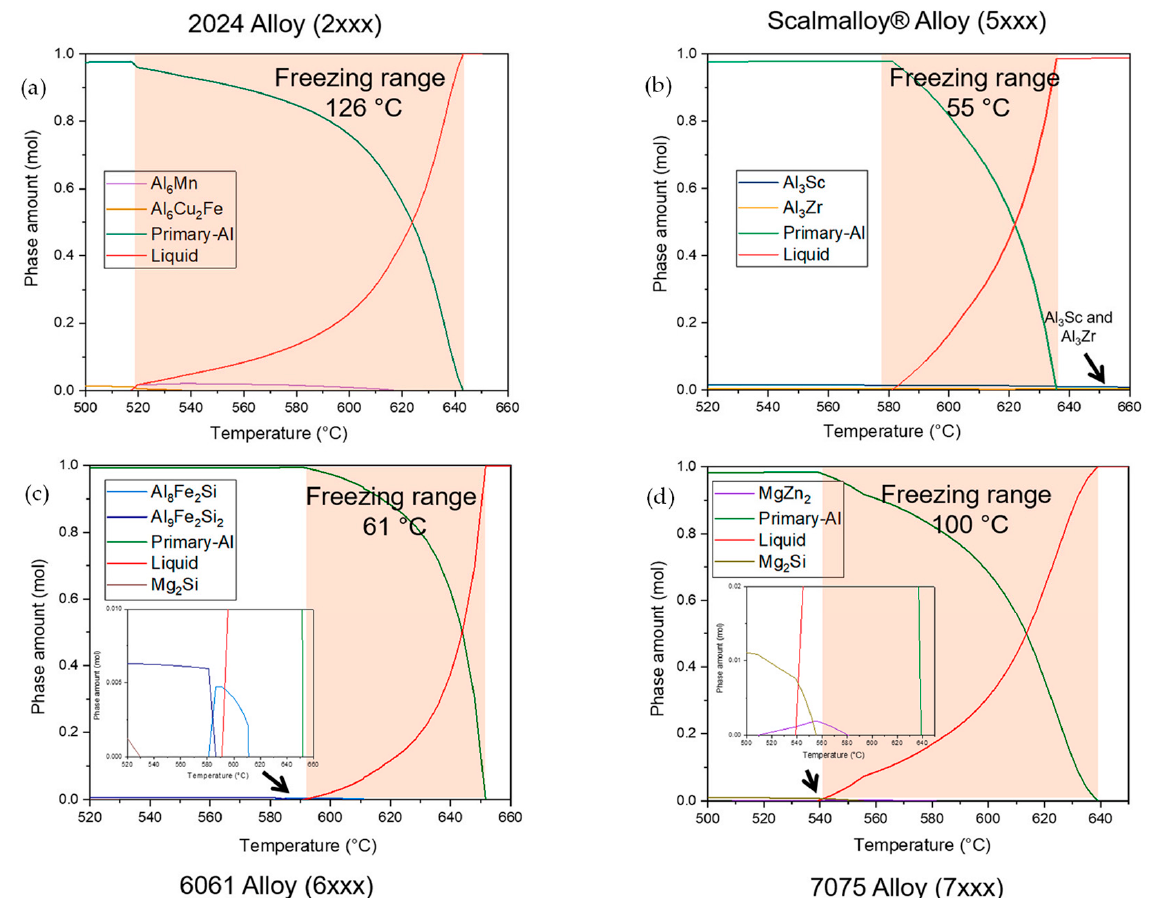
Figure 7. Thermo-Calc generated graphs for the solidification ranges of ( a ) 2024; ( b ) Scalmalloy ® ; ( c ) 6061; ( d ) 7075 alloys. Reproduced with permission from Elsevier [61].